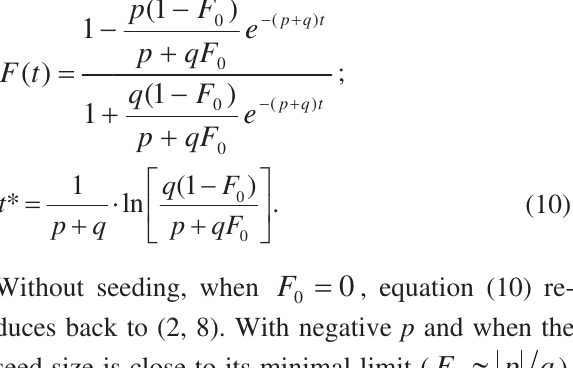
Figure 2 pr curves of t tive p . Wh gle or two has two in when p va the diffusio ment that t the potenti diffusion c there is